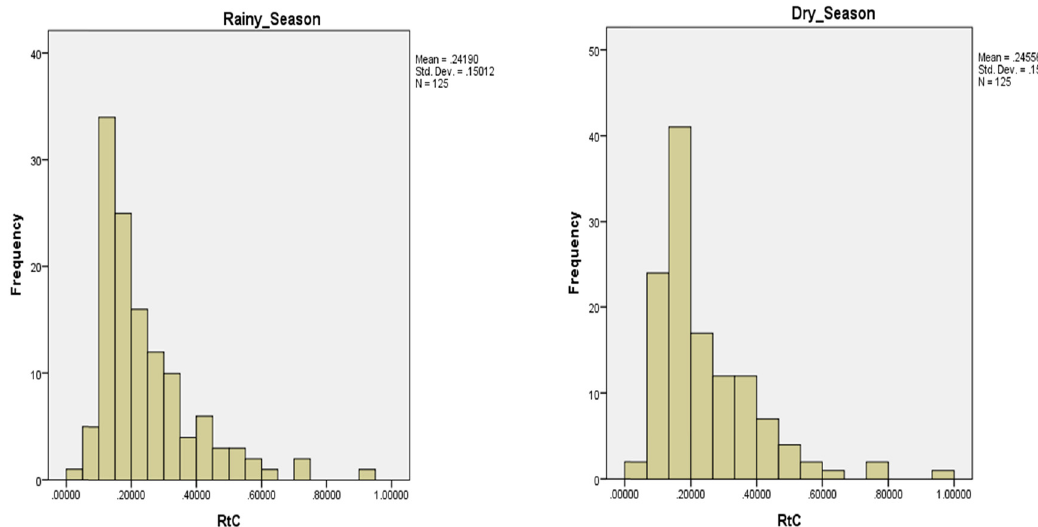
Figure 3: Histogram of the RtC for all observations of rainy and dry season rice